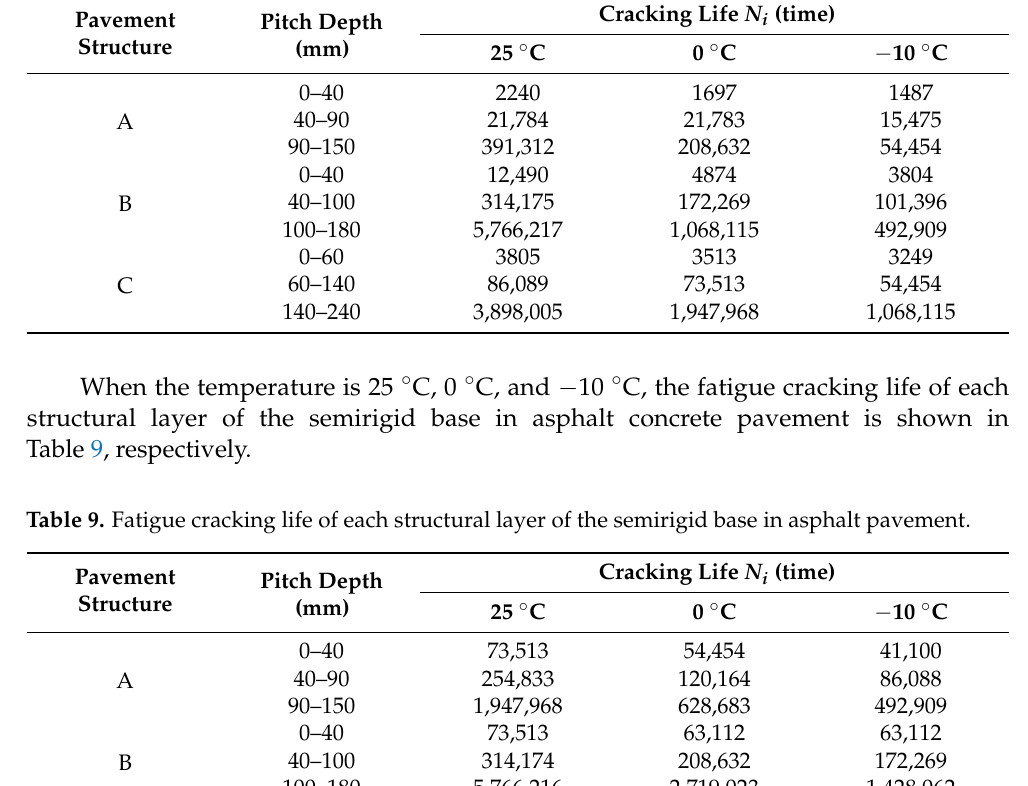
Table 8. Fatigue cracking life of each structural layer of the flexible base of asphalt pavement. Pavement